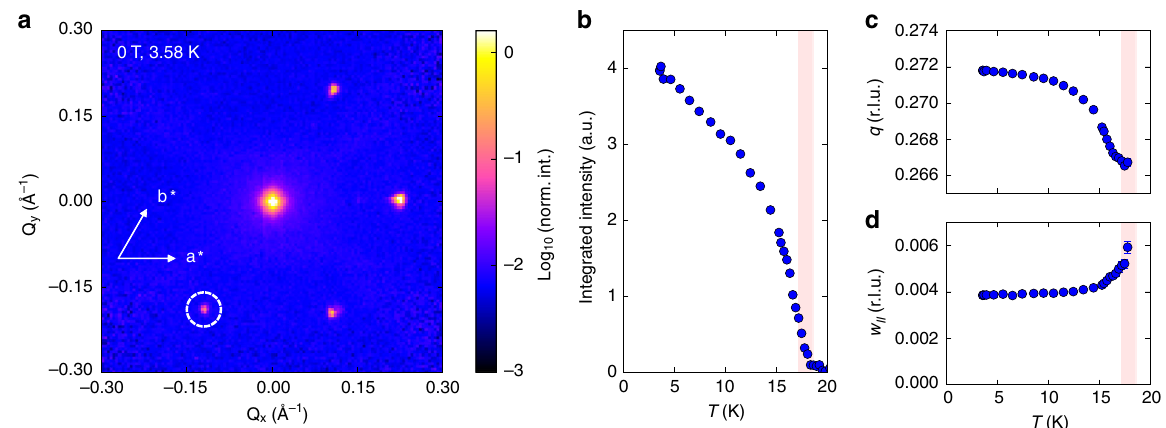
Fig. 5 Small-angle neutron scattering (SANS) experiments as obtained at TAIKAN for 160 Gd enriched Gd 3 Ru 4 Al 12 in H = 0 and at low T . a Q z = 0 cut of scattering intensity in the SANS experiment. Three magnetic re fl ections corresponding to the multi-domain helical ground state are observed. A fourth re fl ection (marked by a white circle) originates from a minority crystallographic domain with different alignment of the c -axis. Scattered neutron intensity is shown on a logarithmic scale. b Integrated intensity of elastic neutron scattering onsets around T N2 = 18.6 K. c Weak temperature dependence of the absolute value of the magnetic modulation vector q = 2 π / λ on the order of 2% was observed. The values of q obtained independently from REXS and SANS on different crystal batches are in good agreement. d Half width at half maximum (w // ) of the magnetic re fl ection in elastic neutron scattering increases as T – d ) is bounded by T T N2 is approached from below. Red shaded area in ( b N1 , N2